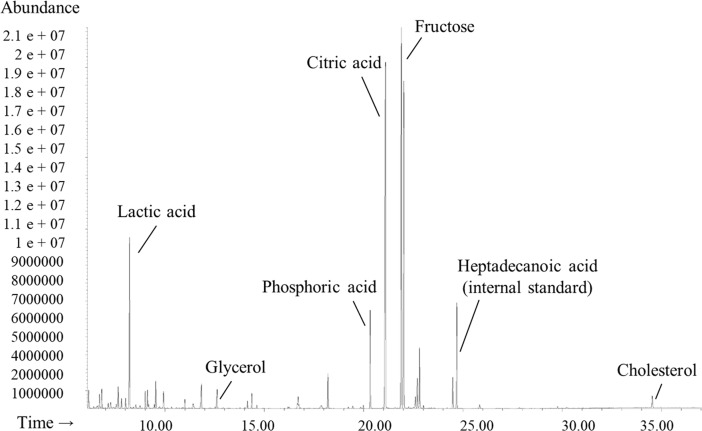
Representative GC-MS chromatogram of bull seminal plasma.Peaks of lactic acid, glycerol, phosphoric acid, citric acid, fructose, heptadecanoic acid (internal standard) and cholesterol are indicated.